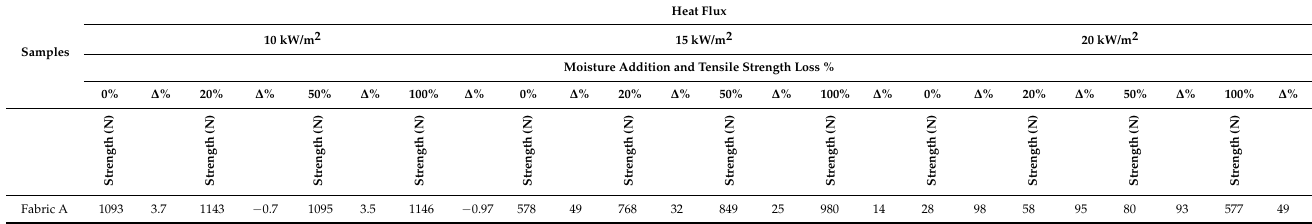
Table 8. Effect of radiant heat on tensile strength (Wet